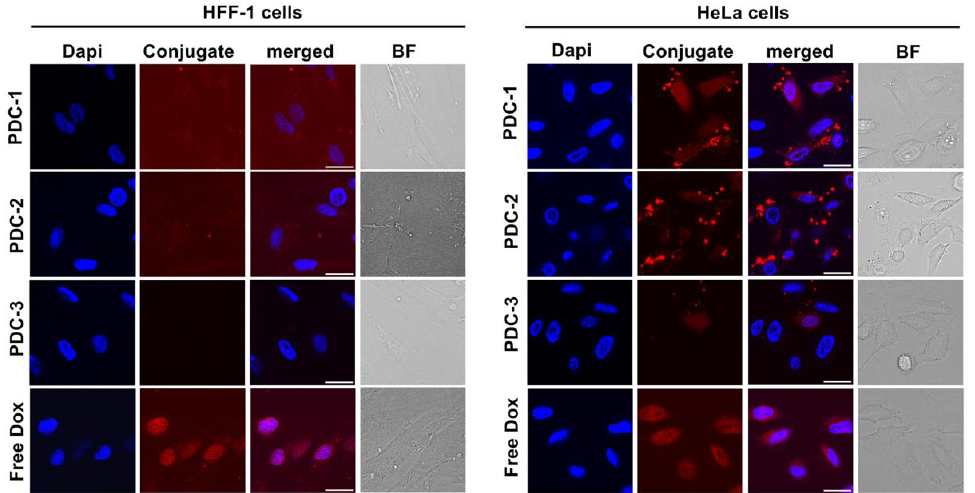
Figure 6. Fluorescence microscope analysis of 5 µM conjugates after 30 min of incubation at 37 °C in HeLa and HFF-1 cells. Red: peptides coupled to red fluorophore Doxorubicin; blue: Hoechst 33342 nuclear stain; BF: brightfield to identify living cells; scale bar is 20 µm.